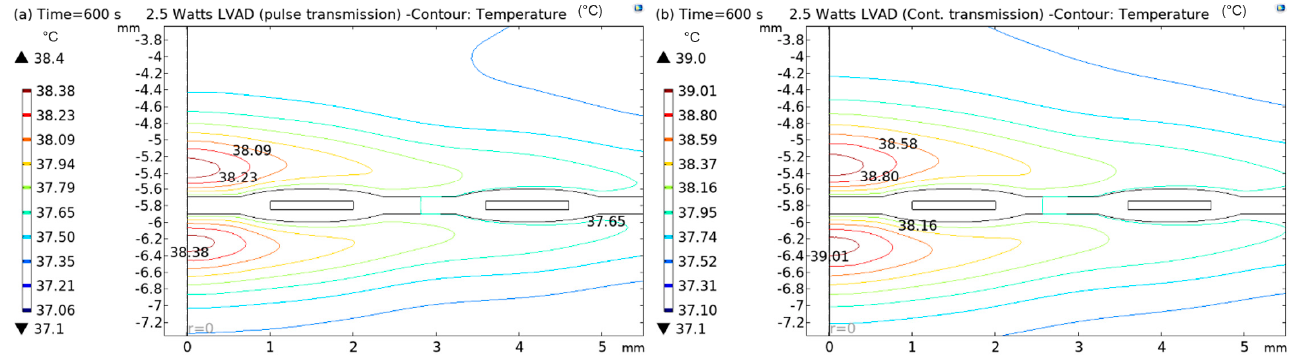
Figure 13. Contour plots of thermal analysis: ( a ) pulsed and ( b ) continuous transmission modes for 2.5 W LVAD.